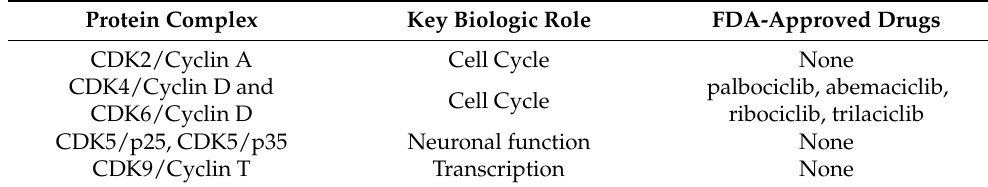
Table 1. Biologic roles of key CDK/Cyclin pairs. Protein Complex Key Biologic